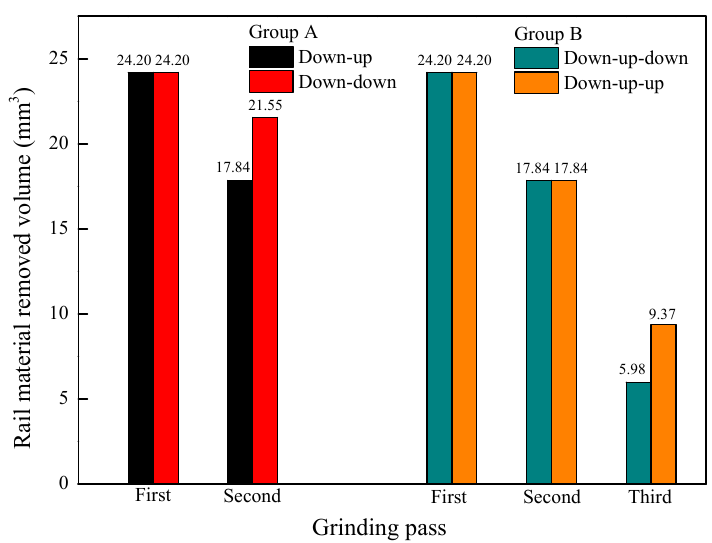
Figure 8. Change in the volume of removed rail material with a change in the grinding direction.